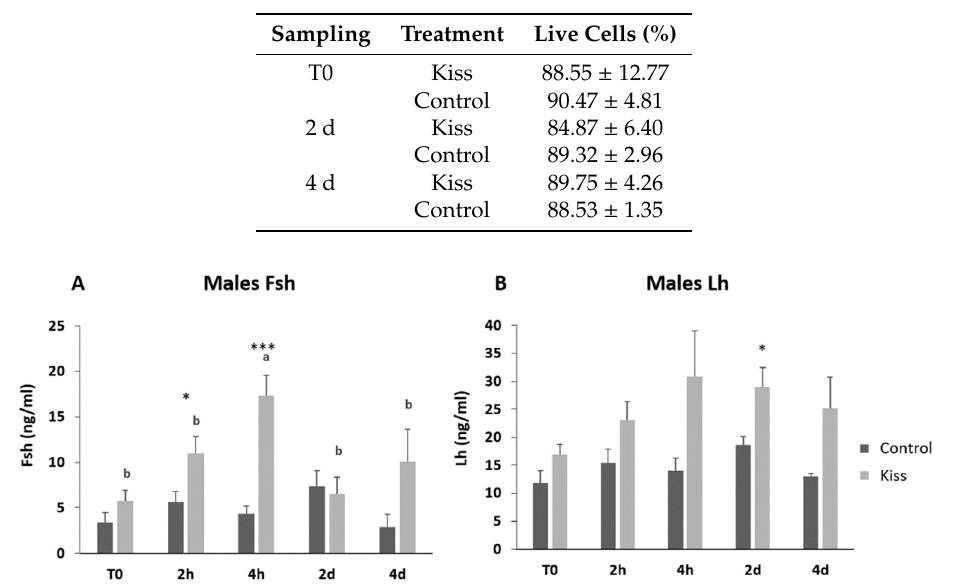
Figure 5. Gonadotropins plasma levels in ng/mL (mean ± SEM) from Senegalese sole males treated with kisspeptin hormone ( n = 17) and control ( n = 13). ( A ) Fsh and ( B ) Lh levels before (T0) and after (2 h: 2-h; 4 h: 4-h; 2 d: 2-days; 4 d: 4-days) the kisspeptin injection. The asterisk denotes significant differences between experimental groups at each sampling point (Student’s t -test; * p < 0.05; *** p < 0.001); different letters indicate significant differences among sampling points within each experimental group (one-way ANOVA, Dunnett’s test, p < 0.05, T0 considered as control point).